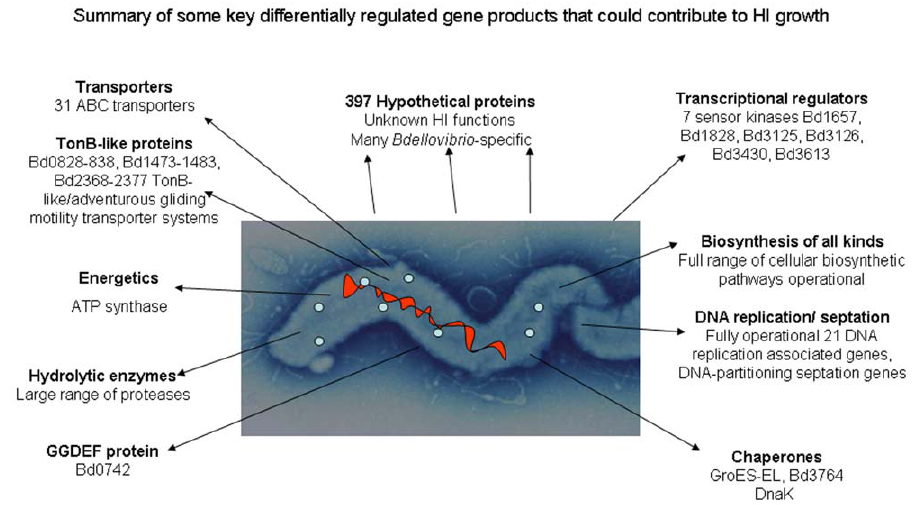
Figure 9. Gene expression key to HI growth phase. Visual summaries of key gene expression characteristics of the HI growth phase of Bdellovibrio cells, as implied by genes highly expressed in the HI dataset, but downregulated in the other two datasets.